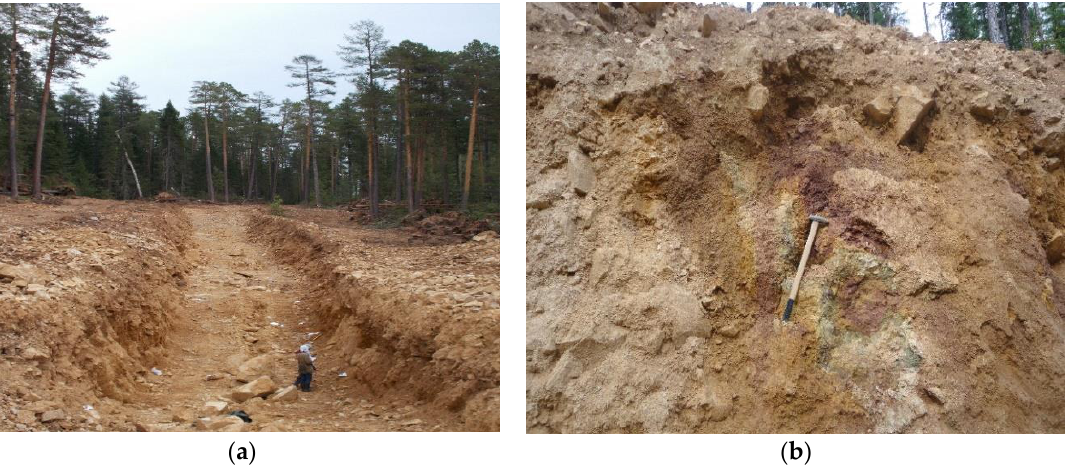
Figure 1. Khokhoyskoe gold deposit, summer 2017: ( a ) exploration trench, ( b ) the place where material with amgaite was sampled. Photo: Larisa A. Kondratieva.